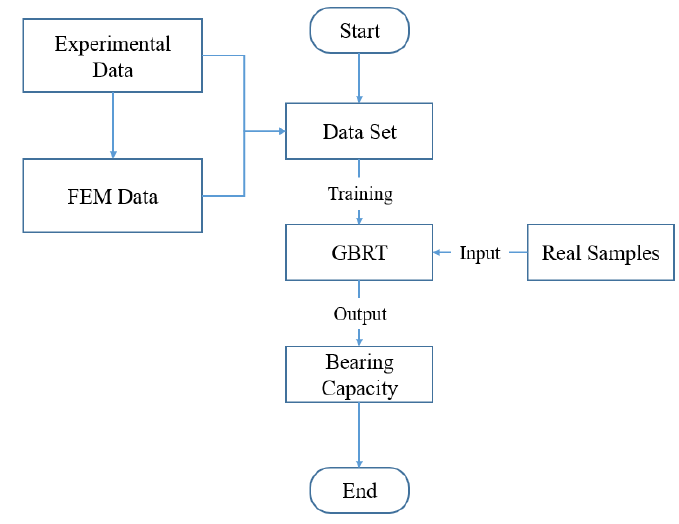
Figure 1. The workflow of the process.